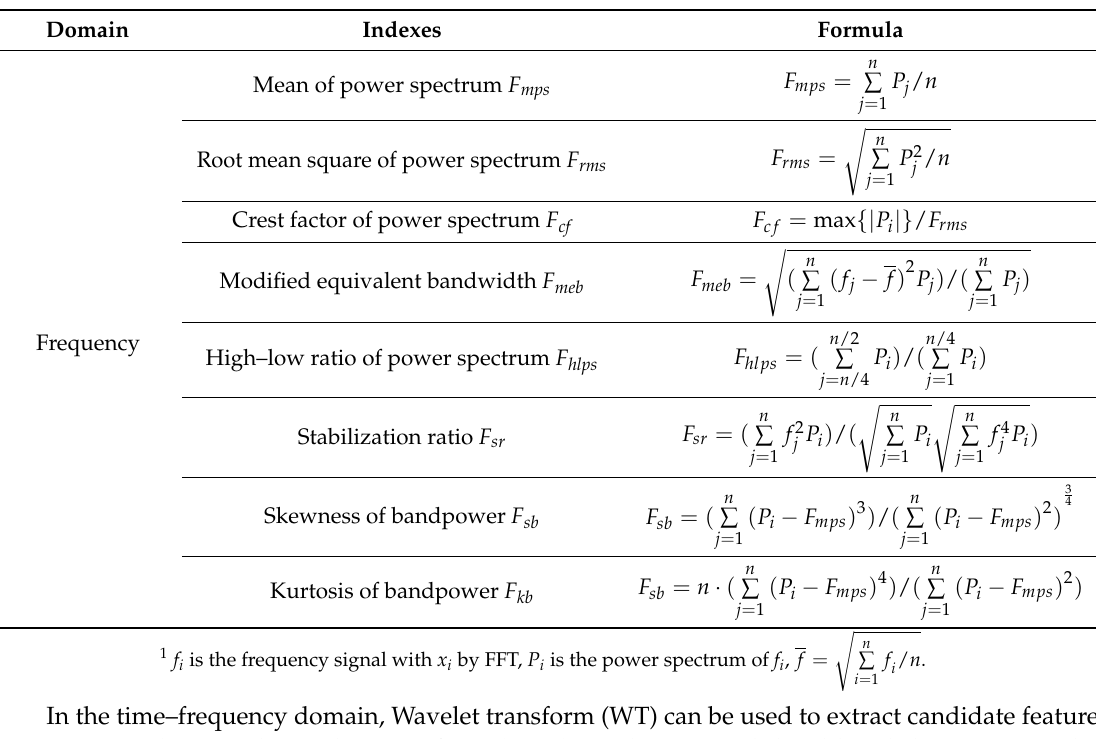
Table 3. Eight frequency domain statistical parameters 1